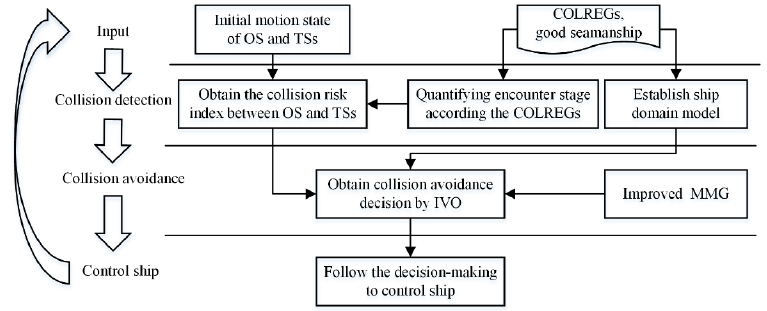
Figure 1. The flowchart of the research methodology.